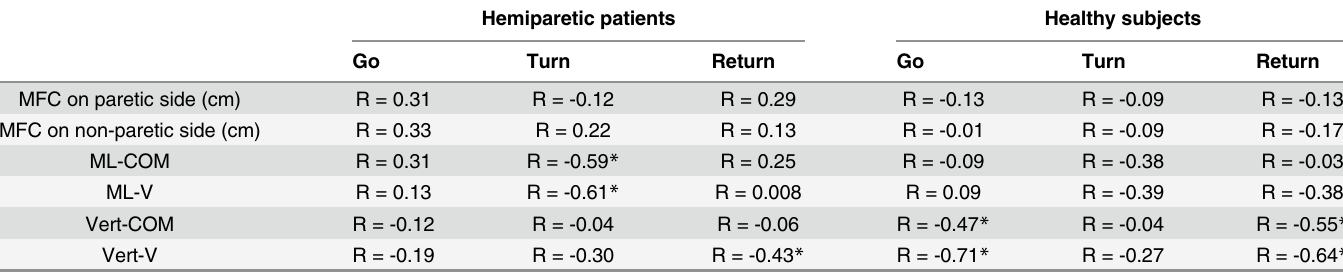
Table 3. Correlations between TUG performance time, and COM and MFC parameters for hemiparetic patients and healthy subjects. Hemiparetic patients Healthy